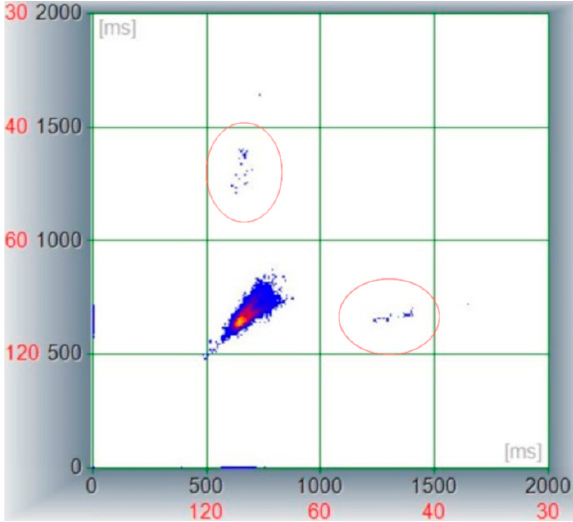
Figure 3. Poincaré plot derived from a 4.5 h Holter recording in a dog with severe azotemia. Note the central cluster lacking avoidance zone and showing a limited distribution among X and Y axes being stacked between 500 and 800 ms (representing a HR between 75 and 120 bpm); the two lateral clusters (encircled areas) are represented by RR pairs including the atrio-ventricular block where the software calculated the previous and following R waves as a “long RR”